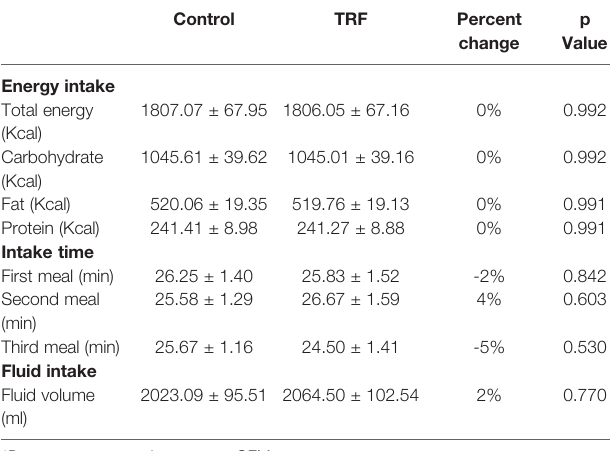
TABLE 2 | Energy intake during 24-Hour TRF versus control